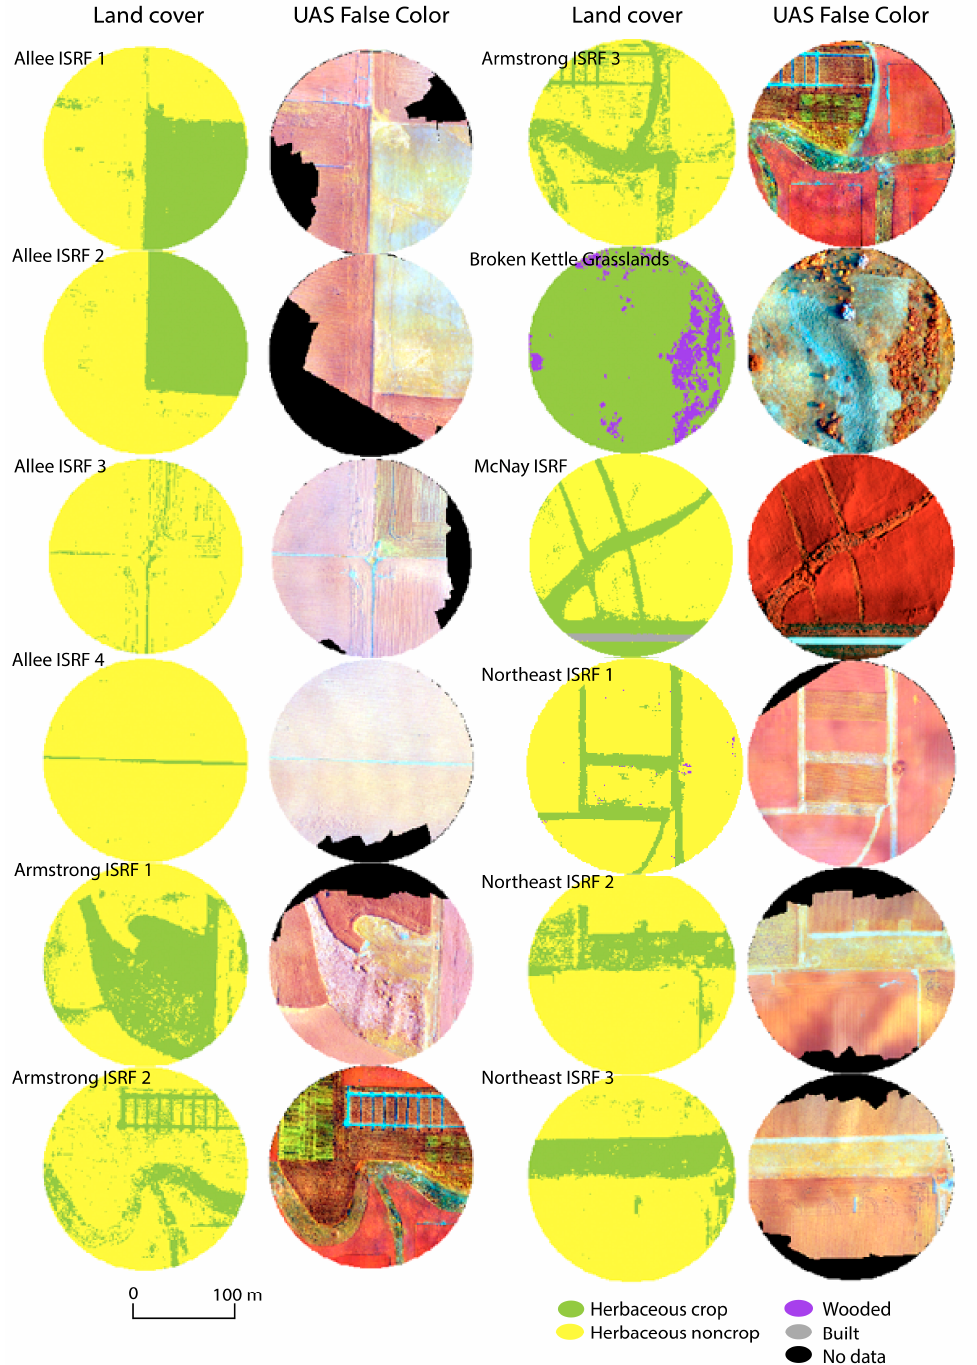
Figure 6. UAS land cover maps and false color images. No data values in raw images were the result of inadequate photographs for computer vision mosaicking. These areas were compared with the 2018 USDA Copland Data Layer [30] and manually reclassified as herbaceous noncrop.